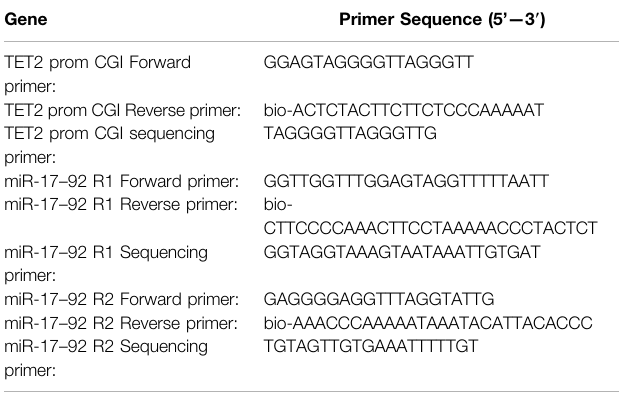
TABLE 4 | PCR and Pyrosequencing primers for TET2 and MIR17HG regulatory regions. Gene